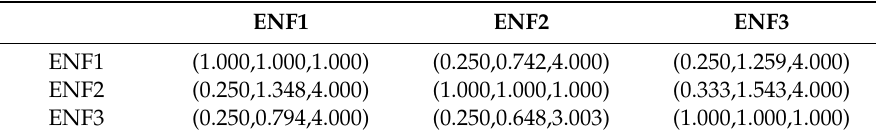
Table A4. Fuzzy pairwise comparison with respect to environmental criteria (ENF).